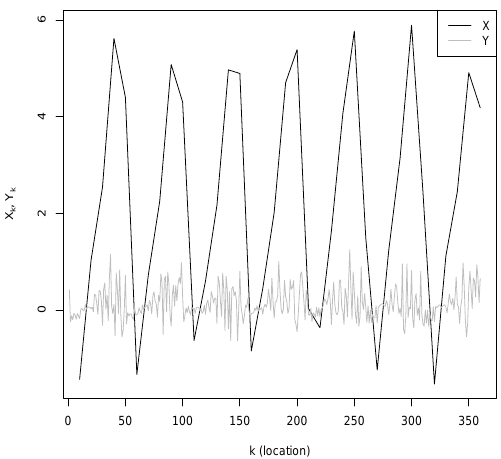
Figure 3. For the partially observed case, locations of observations of X and Y are indicated by the black dots and grey circles, respec-